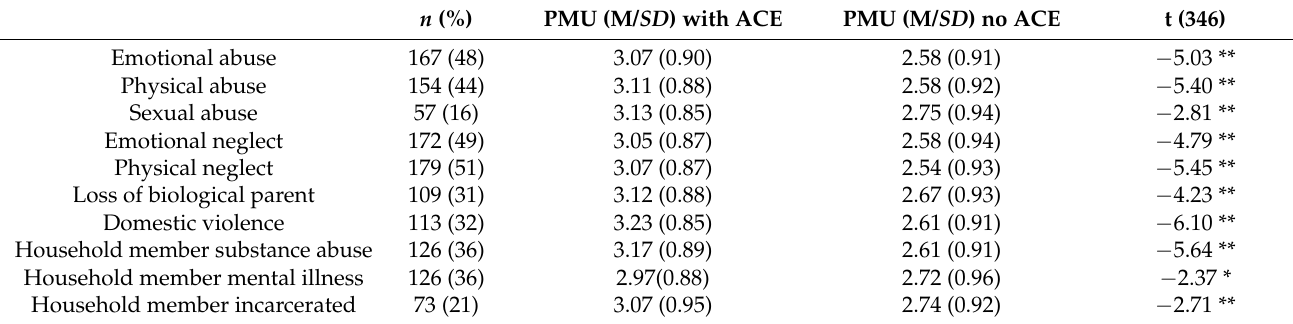
Table 2. Prevalence of ACEs and average problematic media use (PMU) by ACE